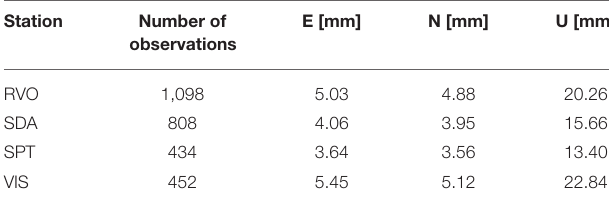
TABLE 4 | Average uncertainties (computed as the mean standard deviations) of GNSS daily solutions used between 26/2/2007 and 10/3/2011 as reported by Bernese software.